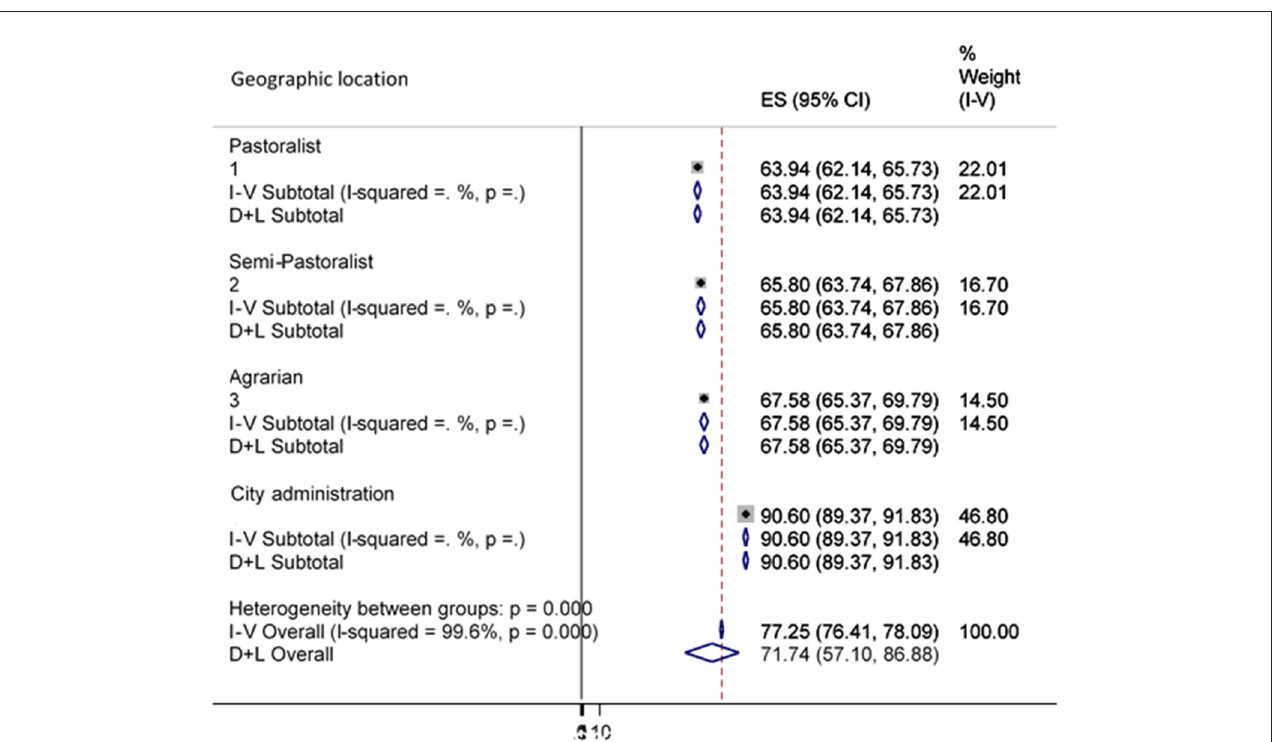
FIGURE4 Sub-group analysis of improved water source by wealth